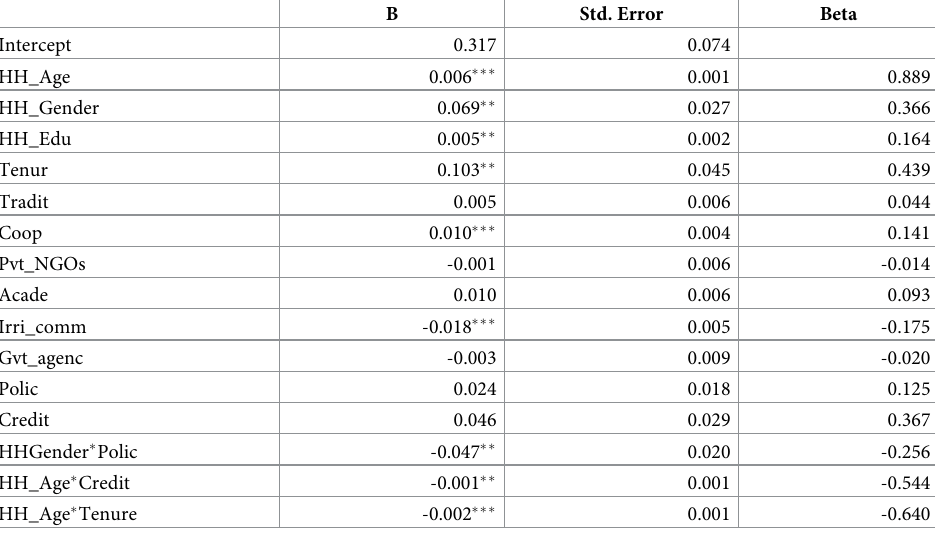
Table 7. Predictors of adaptive